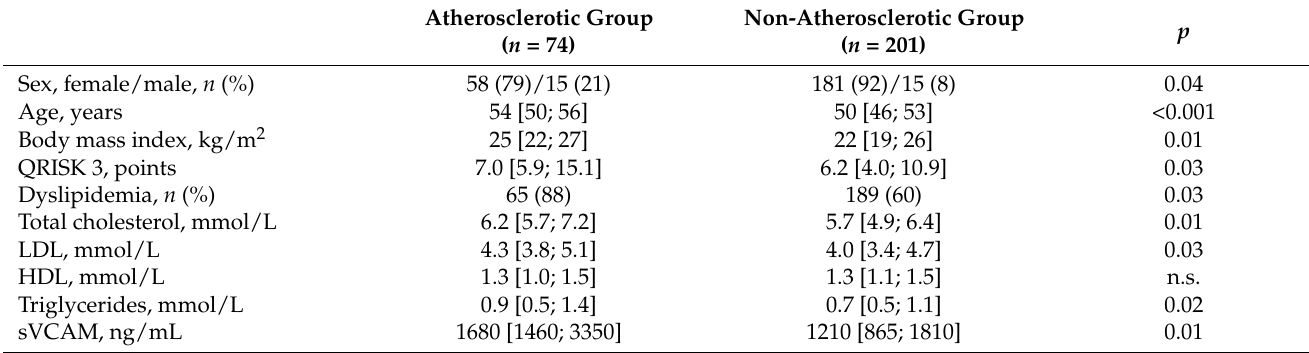
Table 4. Cardiovascular risk factors in atherosclerotic and non-atherosclerotic patients with RA. Atherosclerotic Group Non-Atherosclerotic ( n = 74)